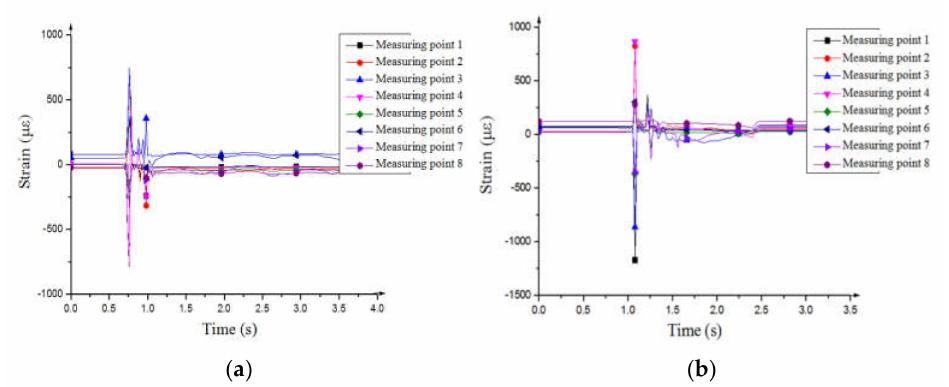
Figure 13. Strain time-history curve of W4 specimen; ( a ) Impact at a height of 1 m; ( b ) Impact at a height of 1.5